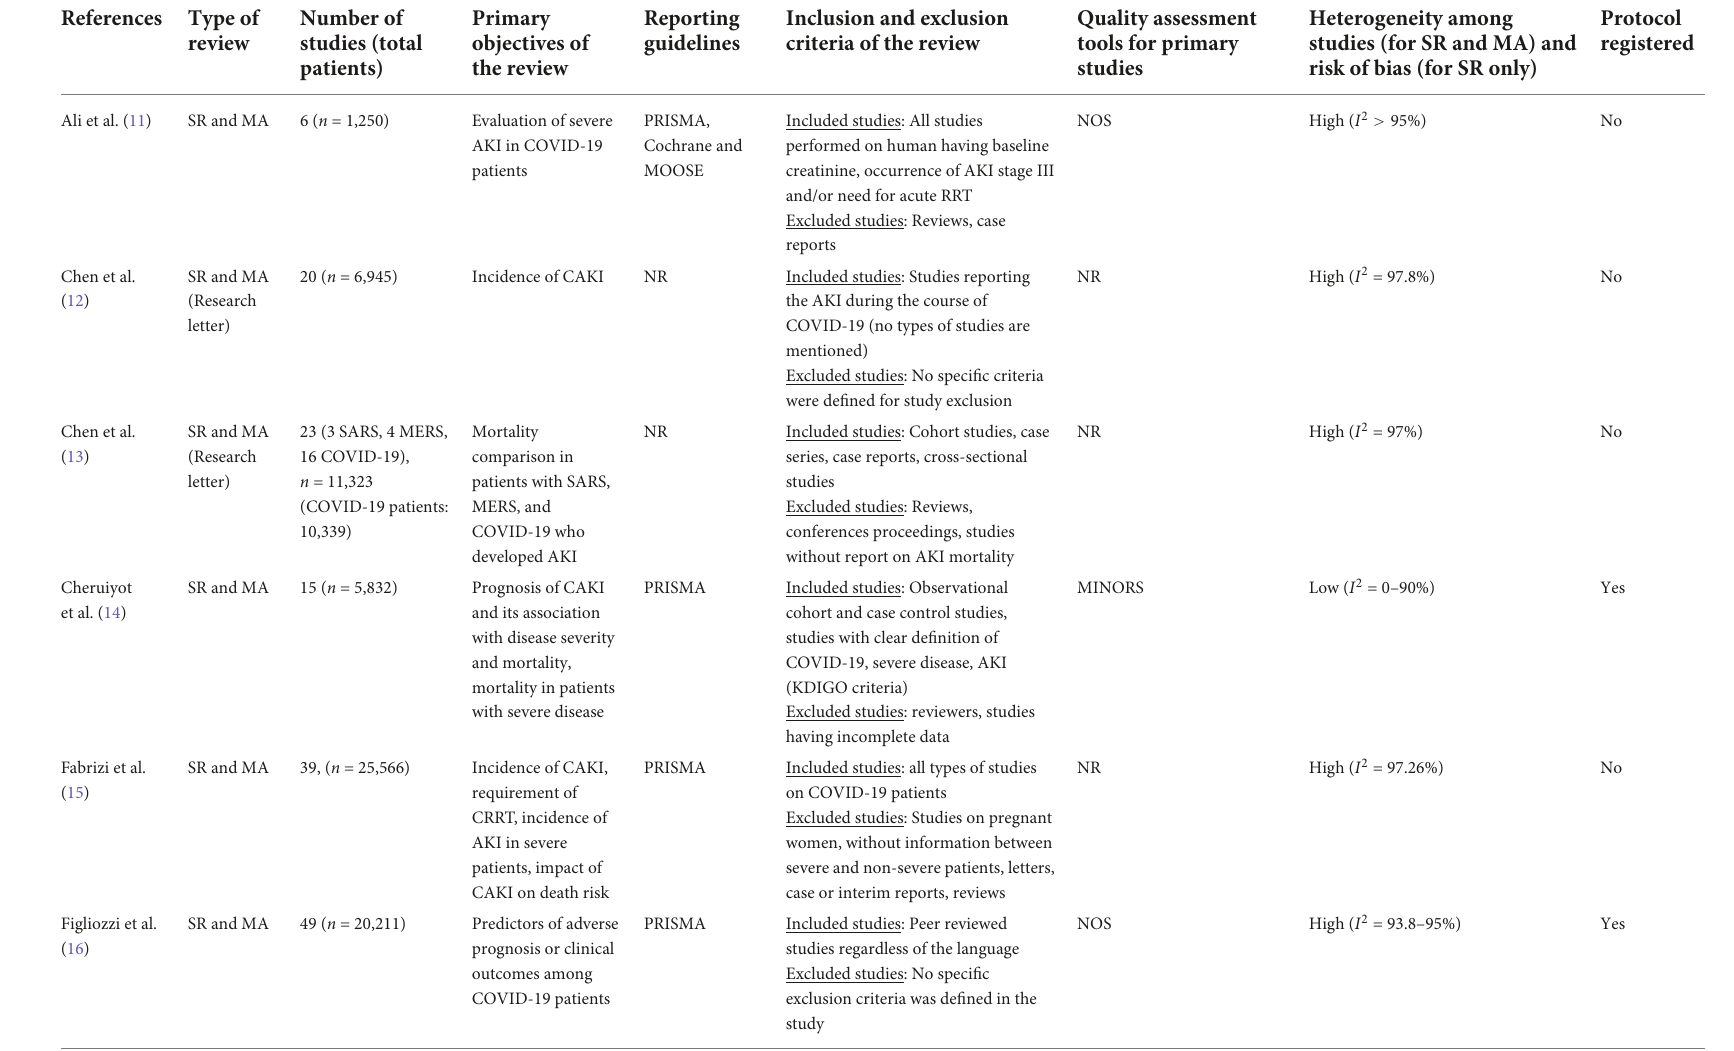
TABLE 2 Methodological summary of included reviews with reported heterogeneity across